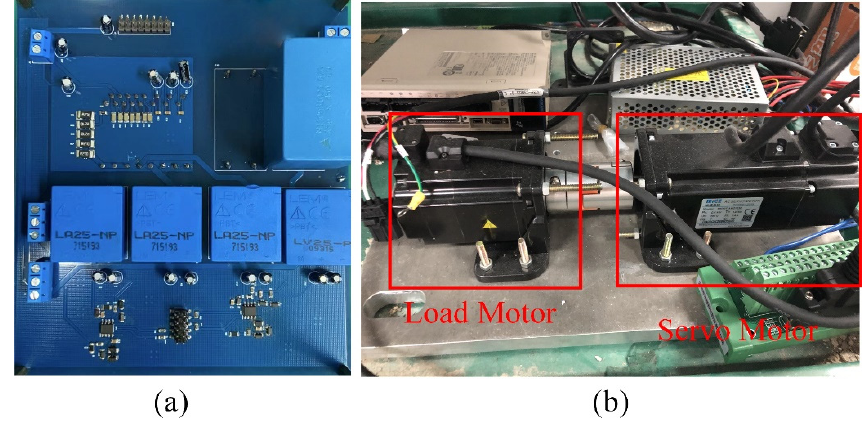
Figure 7. The experiment platform. ( a ) Inverter board. ( b ) The motor platform.